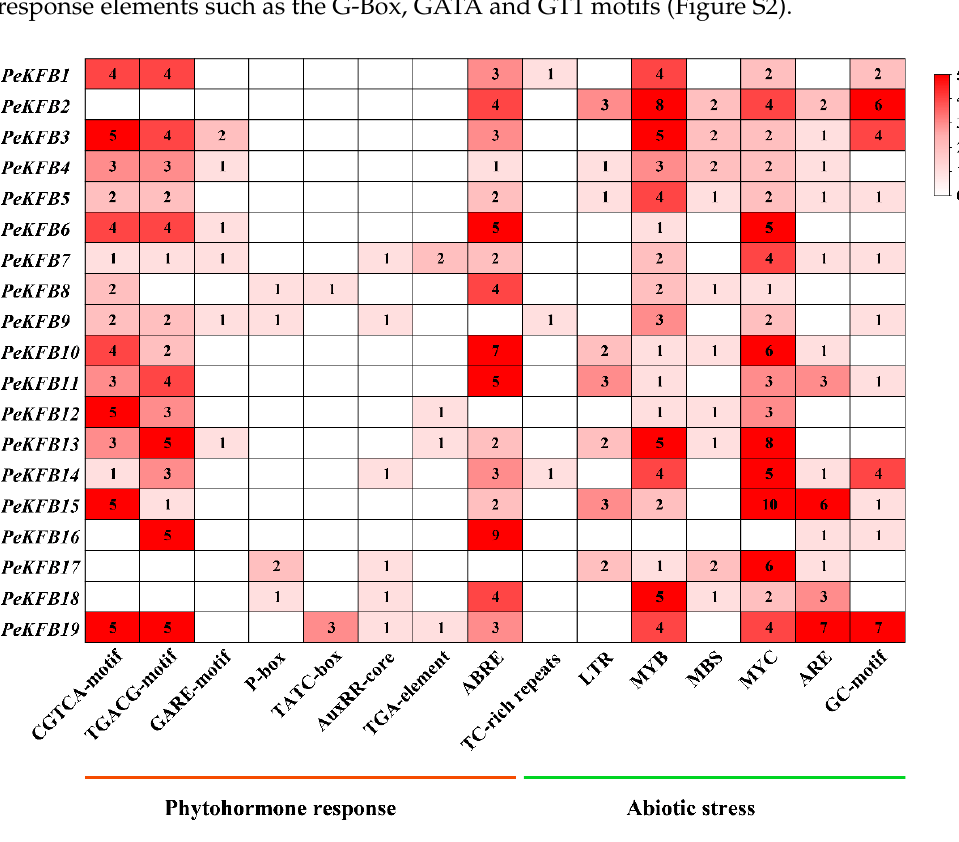
Figure 4. The analysis of conserved cis -elements associated with phytohormone response and abiotic stress in the promoter regions of PeKFB s. The 2000 bp promoter sequences were used to analyze nine specific phytohormone-related (auxin, gibberellin, MeJA, and abscisic acid) cis -elements and three abiotic stress-responsive (anaerobic induction, drought, and low-temperature) cis -elements. The right heatmap shows the number of cis -elements with higher numbers in dark red and lower numbers in light red.